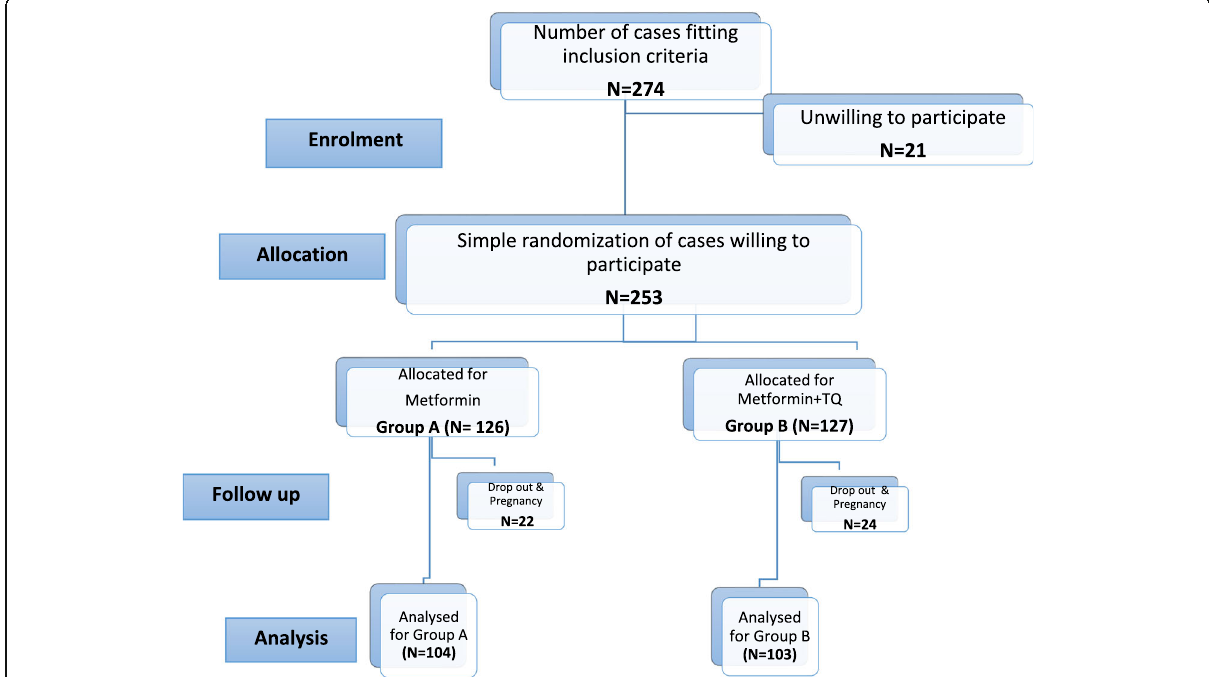
Fig. 1 Flow chart of the study